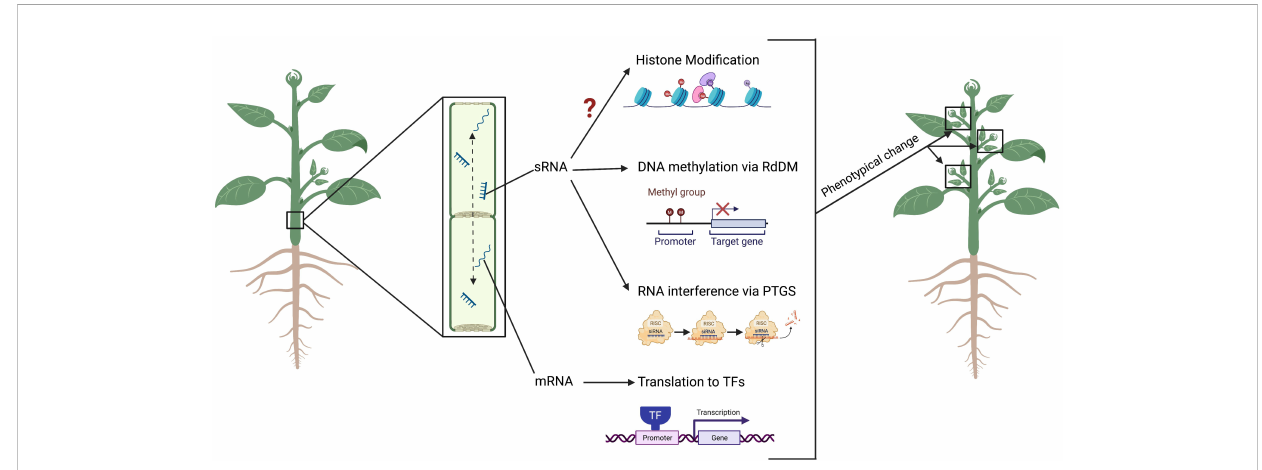
FIGURE 2 The movement of small RNA (siRNA) between root and shoot drive epigenetic modi fi cations and lead to phenotypical changes in the plant. The siRNAs can move both from root-to-shoot and shoot-to-roots directions, via the phloem through the sieve tubes. Once at the destination tissue, the siRNAs can alter DNA methylation at speci fi c loci via the RNA-directed DNA Methylation (RdDM) pathway, or prevent the translation of a gene product via the Post-Transcriptional Gene Silencing (PTGS) pathway. Messenger RNAs (mRNA) can move across a systemically (and across a graft junction) into cells where they are translated into transcription factors (TFs) to control gene expression. Although not yet demonstrated in grafting experiment, siRNAs can introduce histone modi fi cations. Alterations to these epigenetic marks can result in changes to the plant phenotype including resistance to abiotic and biotic stress, as well as alteration in the plant architecture and vigour. Figure created with BioRender.com.